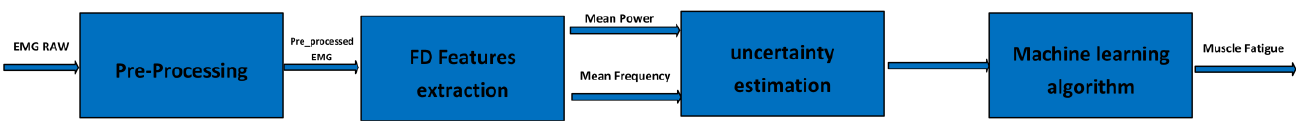
Figure 7. Muscle fatigue estimation approach.